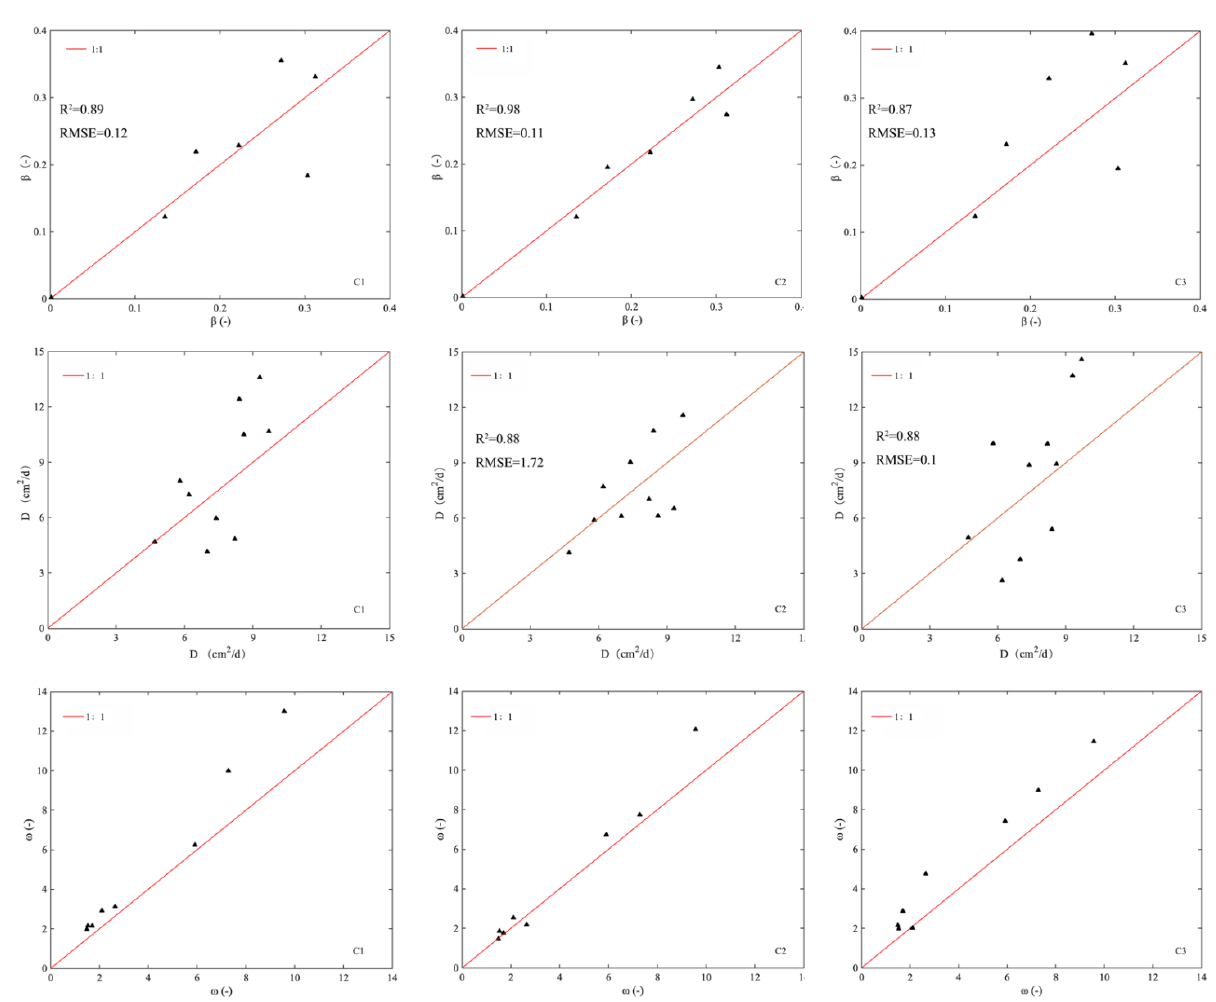
Figure 6. The error of calculated MIM parameters for different concentrations of tracer. (The black triangle represents the calculation error and the red line represents the 1:1 line).